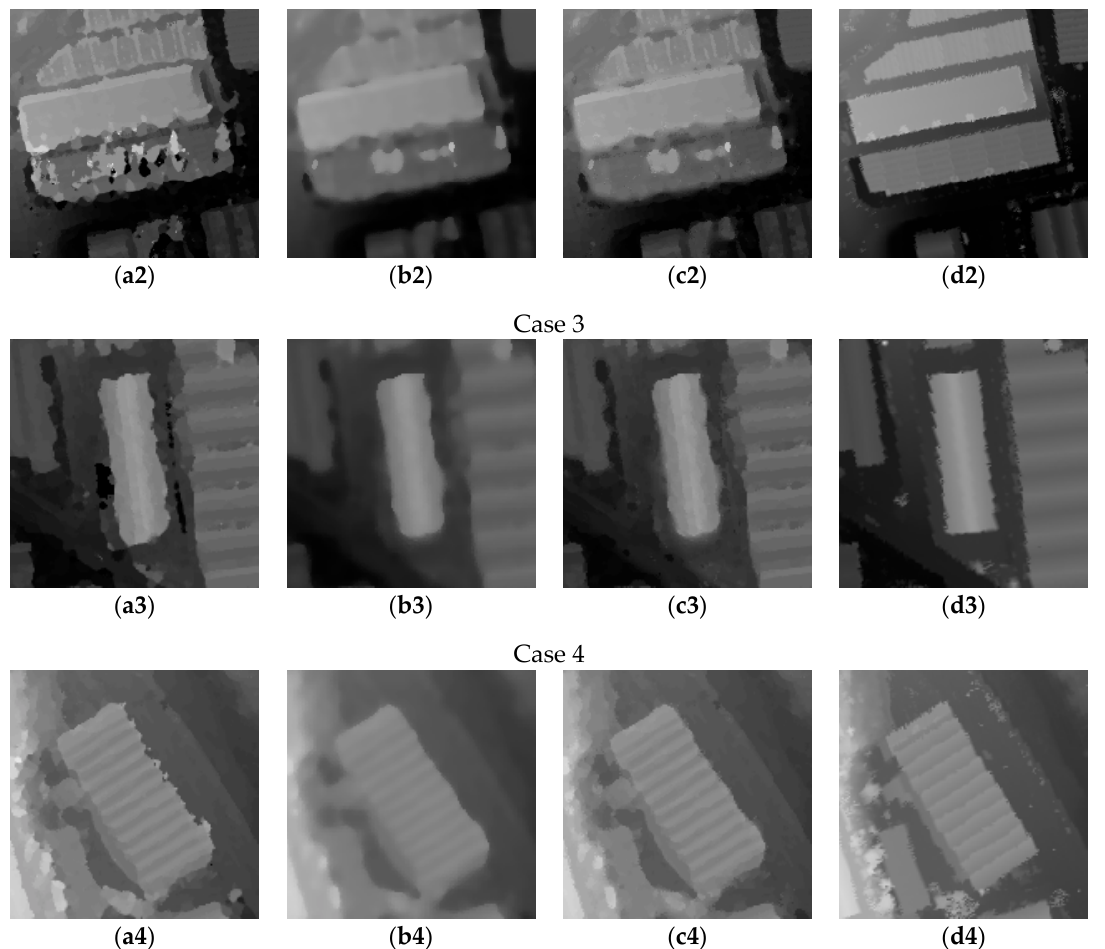
Figure 16. Comparison of the resulting DSMs. ( a1 – a4 ) results from the IDW-based DSM, ( b1 – b4 ) results from the mesh-based DSM, ( c1 – c4 ) results from the integrated DSM, ( d1 – d4 ) results from the reference DSM.